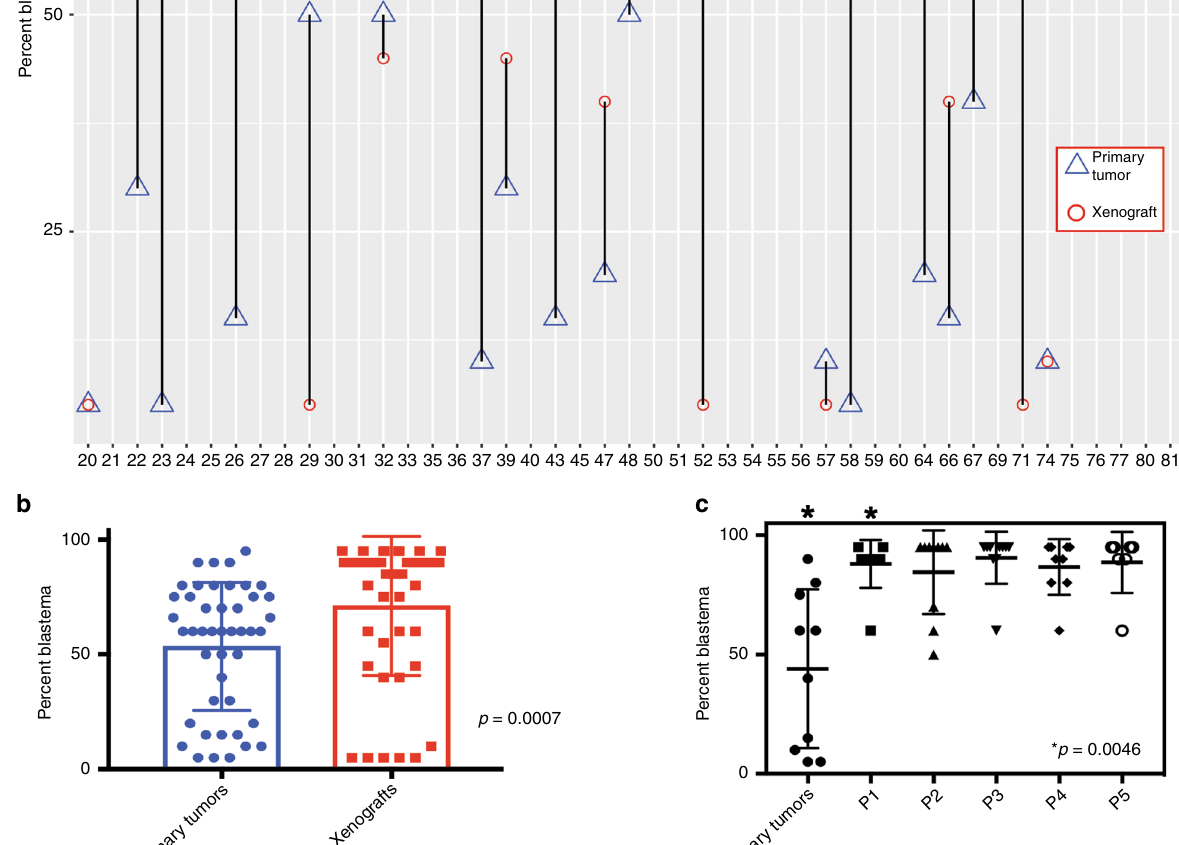
Fig. 7). Of note, WTPDX showed negative in fi ltrating murine